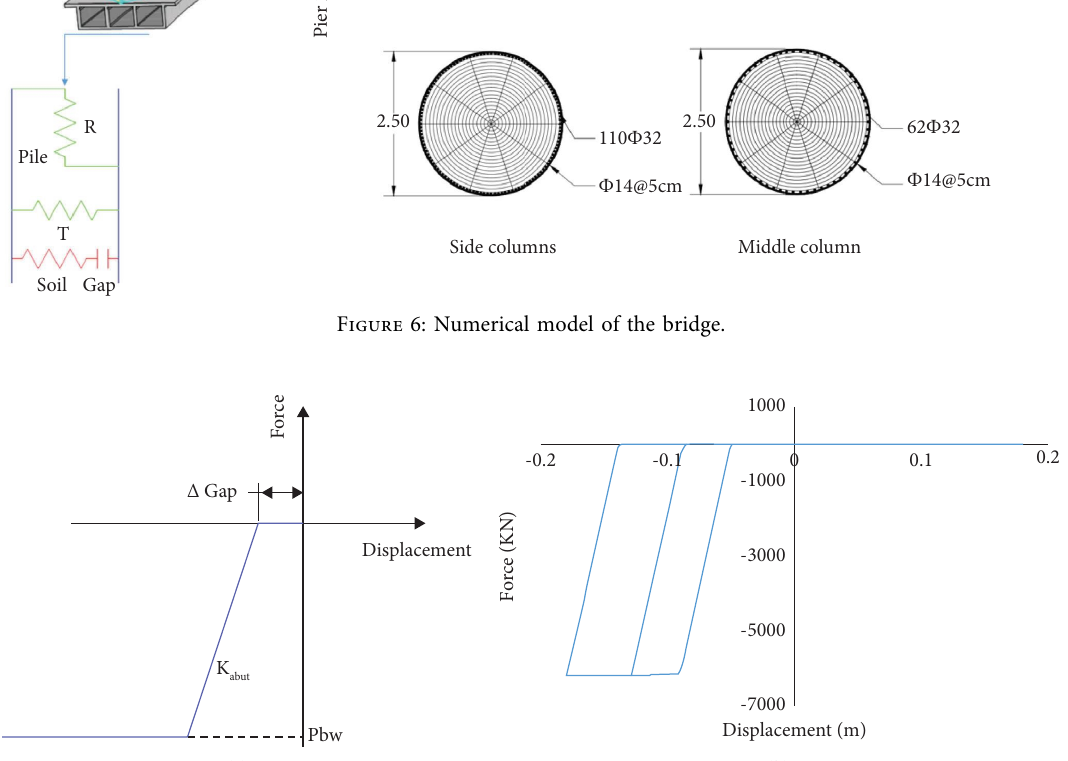
Figure 7: (a) Backbone curve [41] and (b) cyclic behavior of the backfll soil.